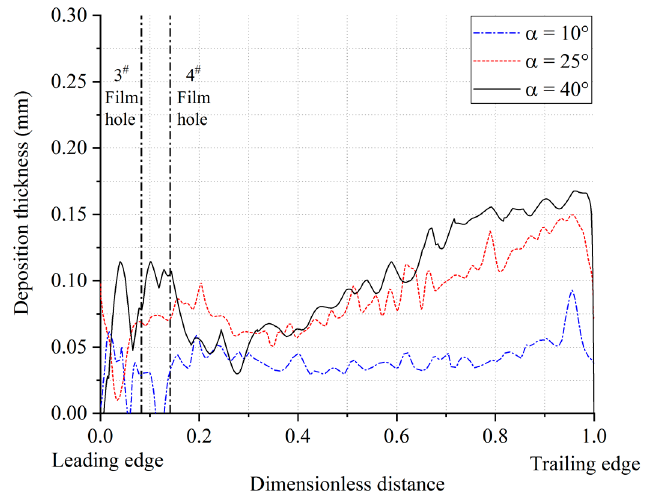
Figure 23. Surface deposit thickness plot for the suction side of the test models angled at 10°, 25° and 40° (cross-section at midspan).